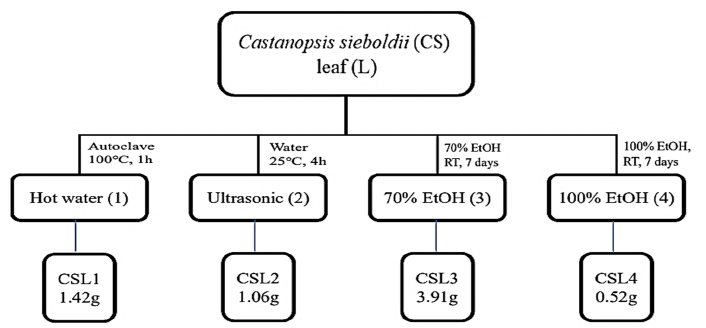
Figure 1. Schematic diagram of extraction methods of Castanopsis sieboldii leaves.